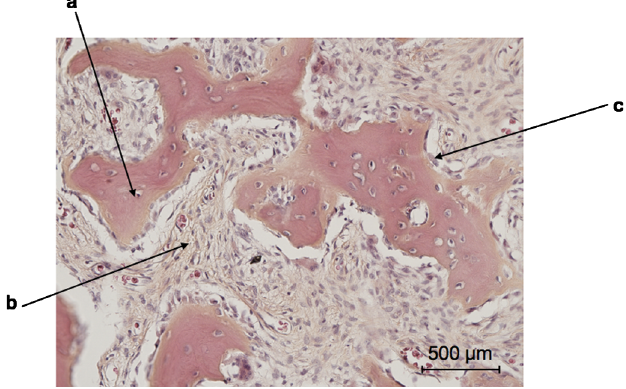
Fig. 5. Histological section of the largest fragment. H&E staining (a) bone spans of irregular contours; (b) very cellular collagenic background; (c) osteoblastic border testifying to tumor aggressive- ness, speci fi c to the trabecular form of JOF.